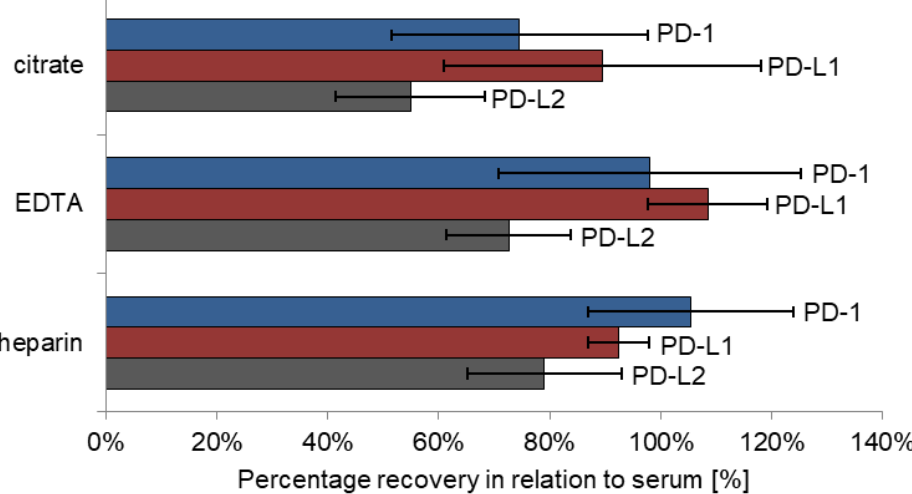
Figure 3. Matrix comparison recovery relative to serum concentration.